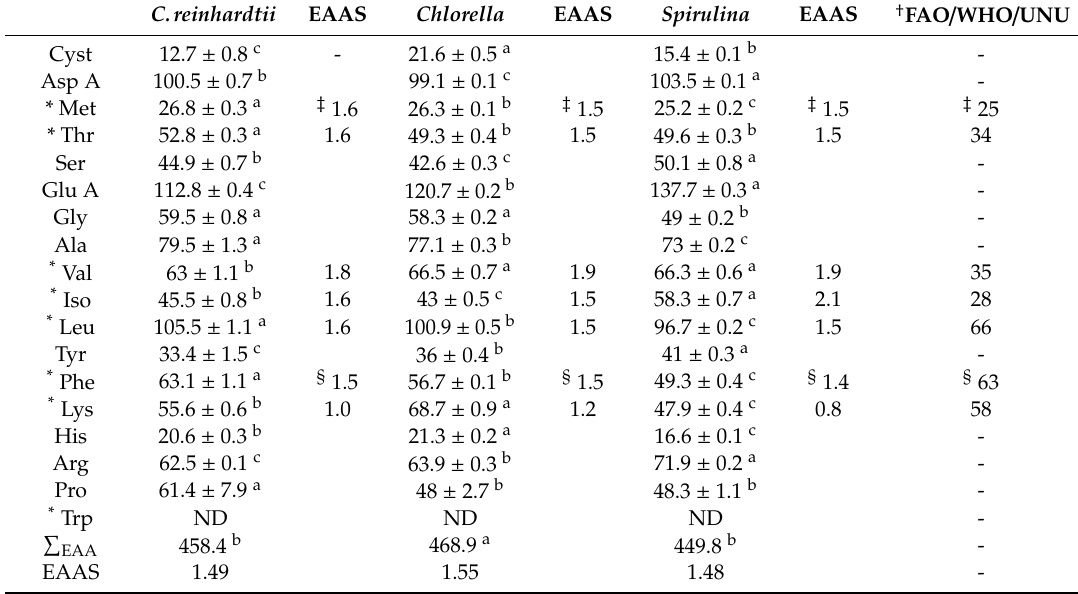
Table 1. Amino acids composition of C. reinhardtii, Spirulina and Chlorella, expressed as mg / g